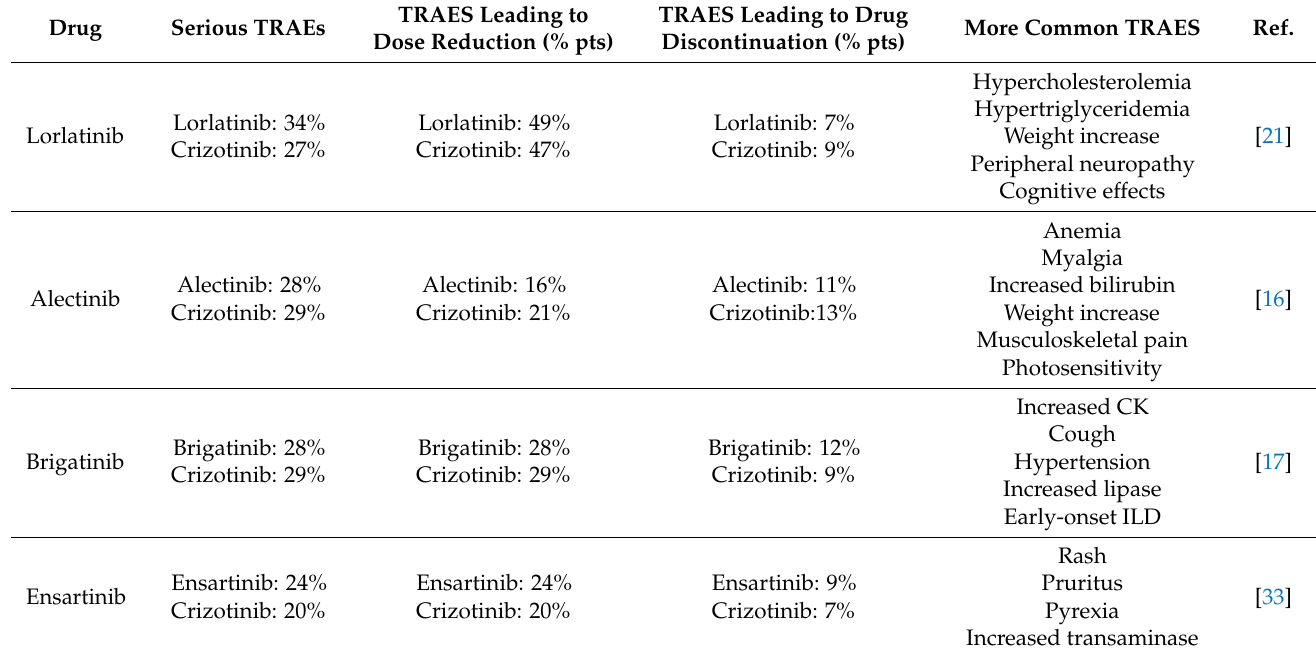
Table 2. Safety and toxicity profiles of next-generation ALK TKIs in trials compared with